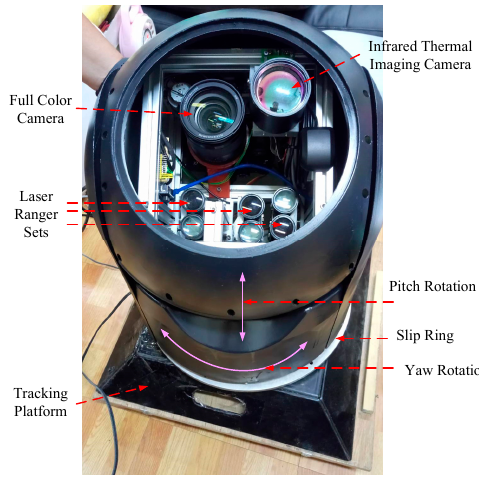
Figure 1. Design of the dual-axis mechanism.